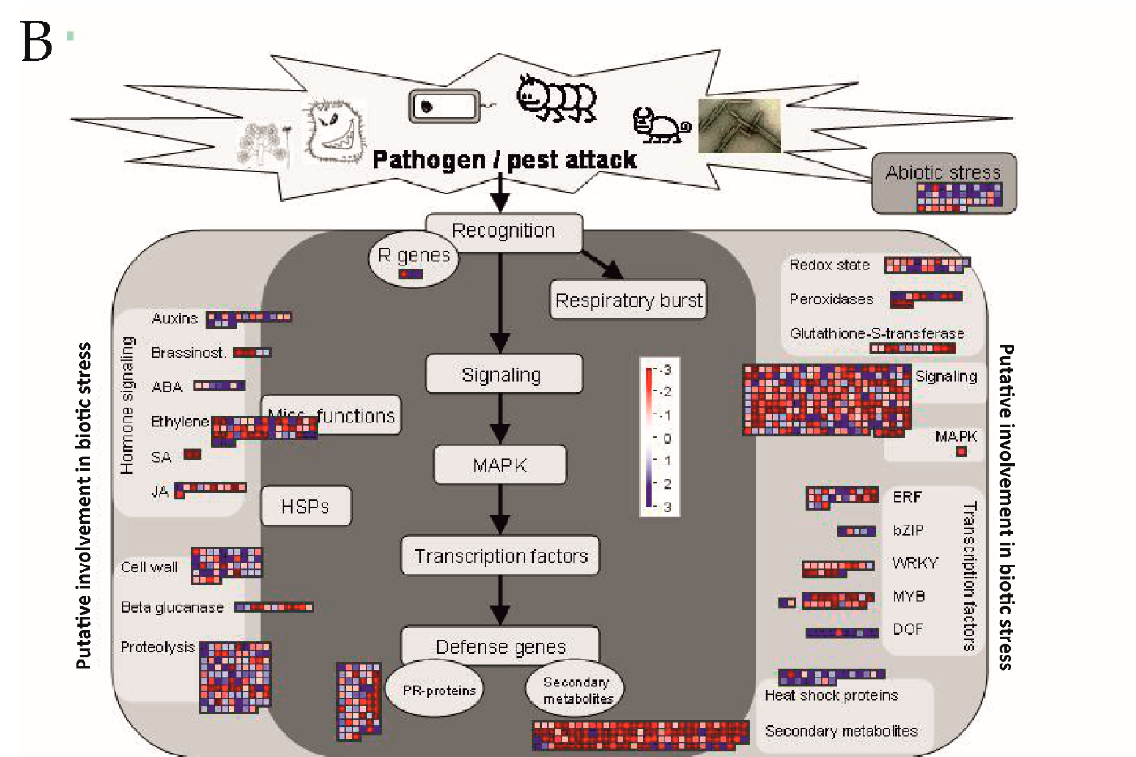
Figure 4. Metabolic ( A ) and biotic stress ( B ) overviews using MapMan to compare the transcript accumulation in the albedo of the freshly harvested fruit vs. the flavedo of the samples taken from the peel of the same fruit. Red and blue squares represent DEGs with decreasing and increasing transcript levels in albedo vs. flavedo. Only the DEGs that met a cut-off of |Log 2 FoldChange| ≥ 1 were included in the analysis. The color scale, ranging from − 3 to 3, is indicated in the figure and is expressed as a log 2 fold change.